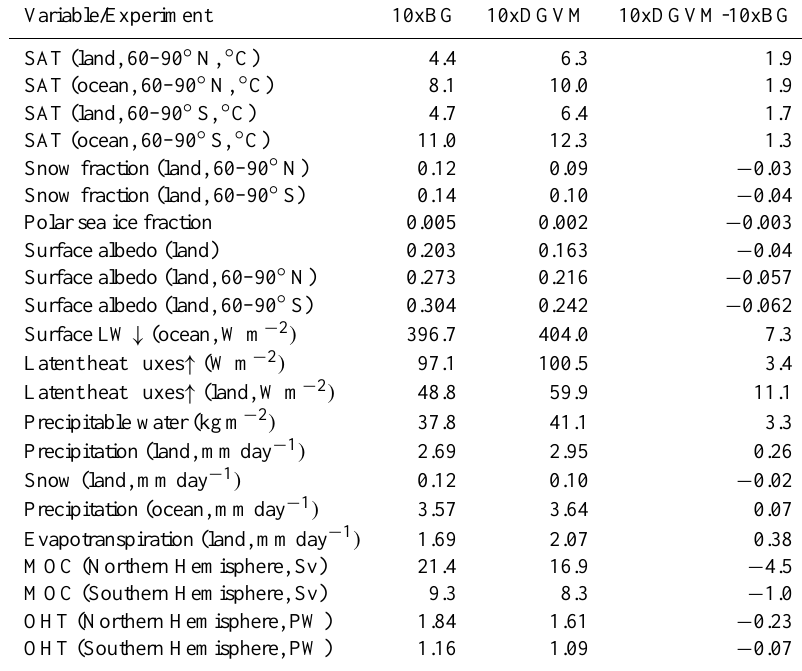
Table 3. Global and high-latitude annual mean climatic variables in the 10xBG and 10xDGVM experiments. Variable/Experiment